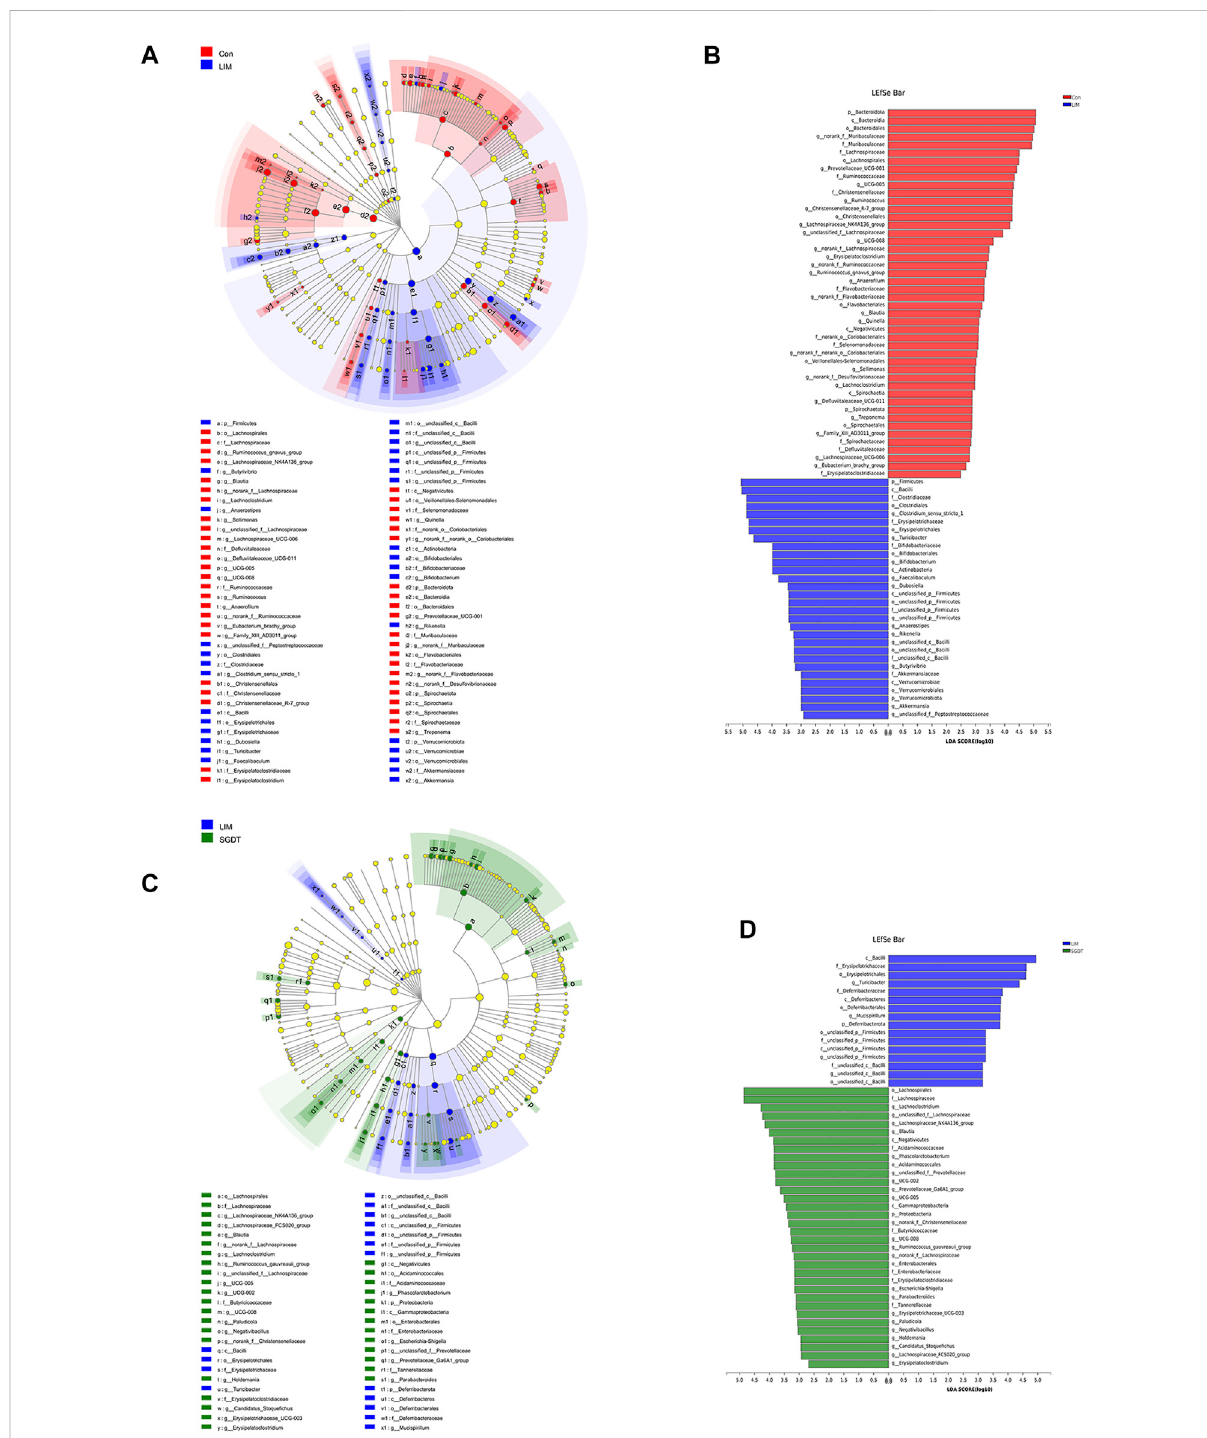
FIGURE 1 Key bacterial taxasigni fi cantly alteredinCCl 4 -inducedliver injury andSGD treatment. (A) Cladogram generated byLEfSe analysisbetweenCon and LIM. (B) LDA scores of enriched taxa inLEfSe analysisbetweenConand LIM. (C) Cladogram generated by LEfSe analysis between LIM and SGDT. (D) LDA scores of enriched taxa in LEfSe analysis between LIM and